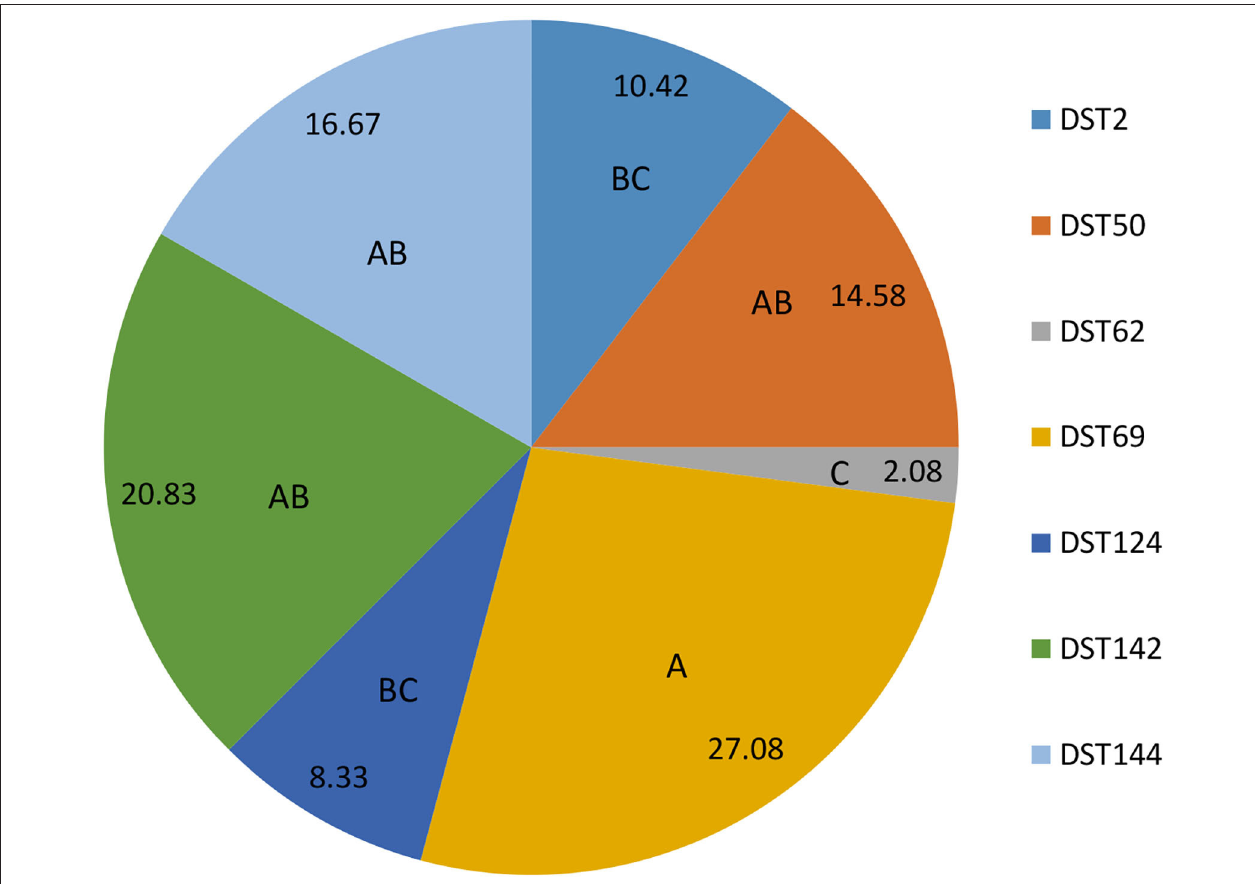
FIGURE 5 | The frequent identification of different diploid sequence types (DSTs) of C. albicans isolates from milk and genital tract of dromedary camel. A.B.C Percentages carrying different capital letters differed significantly ( p ≤ 0.05).